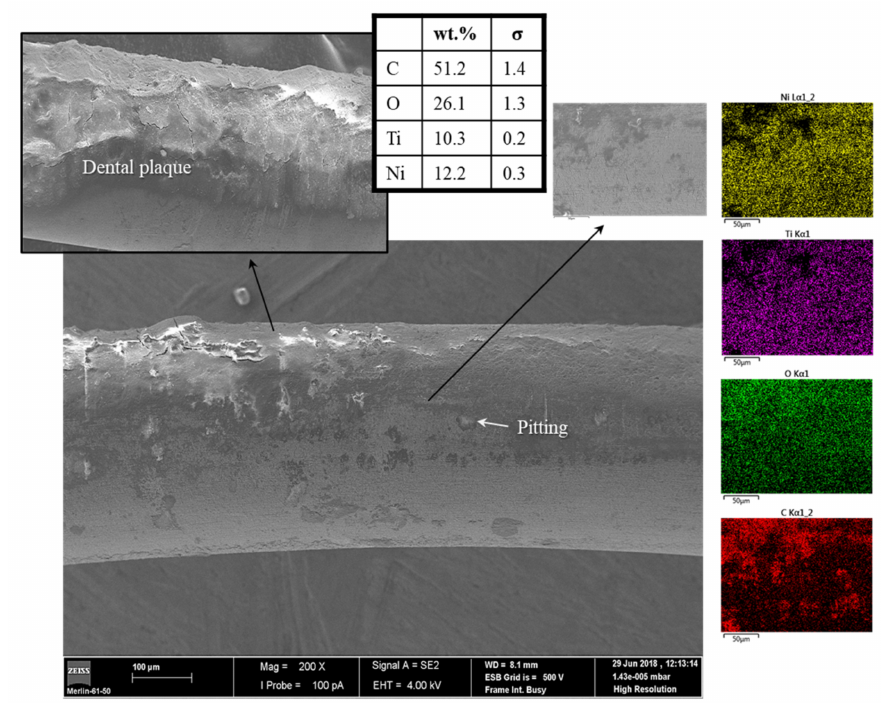
Figure 3. SEM micrographs and energy dispersive spectroscopy (EDS) elemental distribution maps of the NiTi archwire from patient P8–17 weeks of intraoral use.